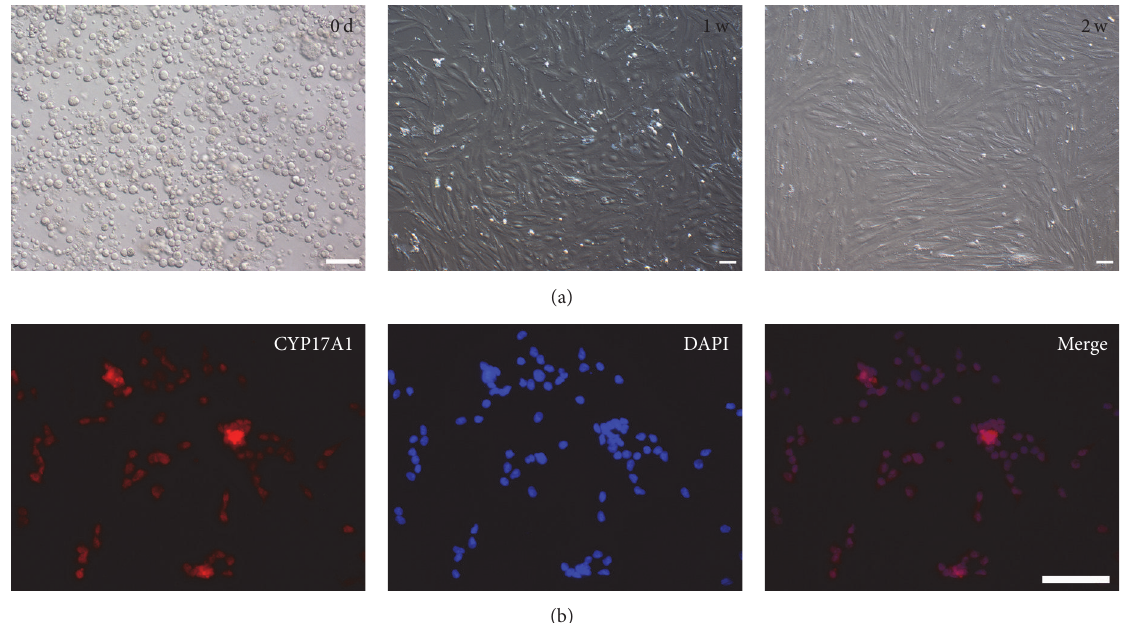
Figure 4: Morphology development and CYP17A1 immunofluorescence of porcine SLCs cultured in basic medium. (a) Morphology development of porcine SLCs cultured 0d, 1w, and 2w in basic medium. (b) CYP17A1 immunofluorescence of porcine SLCs cultured in basic medium for 2